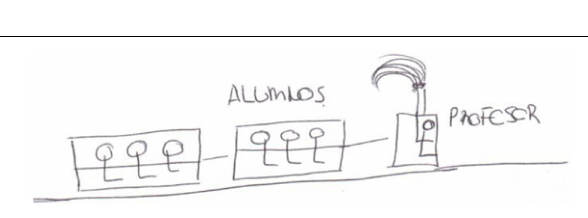
FIGURE 8 | Drawing of the teacher and pupils as mountain climbers.